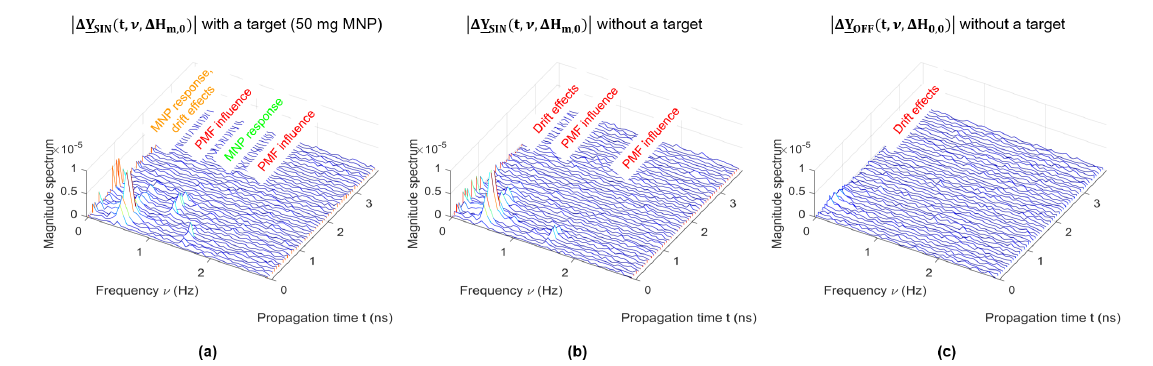
Figure 14. Fourier transform over observation time of the clutter removed radargrams according to Equation (24) of one channel for different scenarios. ( a ) SIN modulation with a 2 mL target with an MNP concentration of 25 mg/mL. ( b ) SIN modulation without a target. ( c ) Without a target and no presence of an external